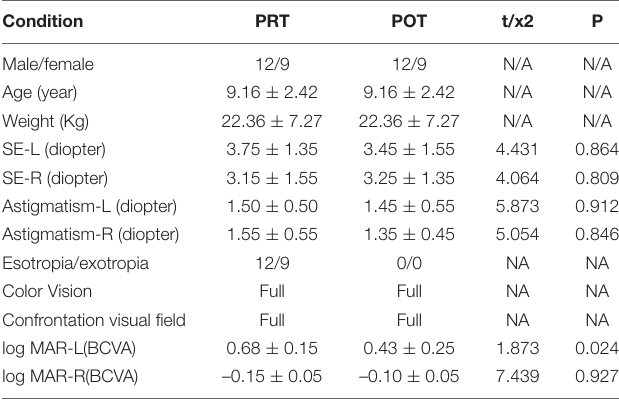
TABLE 1 | Demographics and clinical measurements of pre-rTMS (PRT) and post-rTMS (POT). Condition